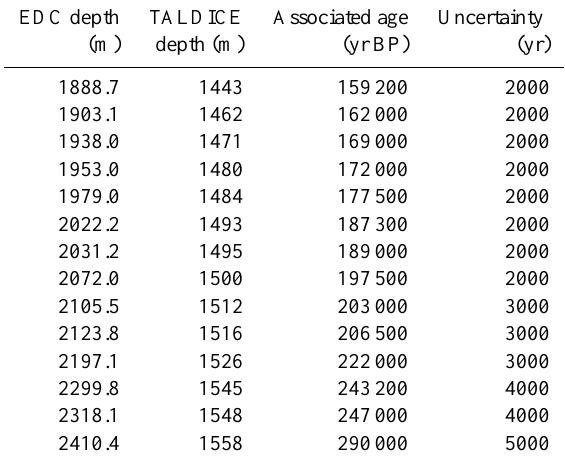
Table 3. Tie points defined by water isotopic record synchroniza- tion between TALDICE and EDC ice cores based on the EDC3 age scale. EDC depth TALDICE Associated